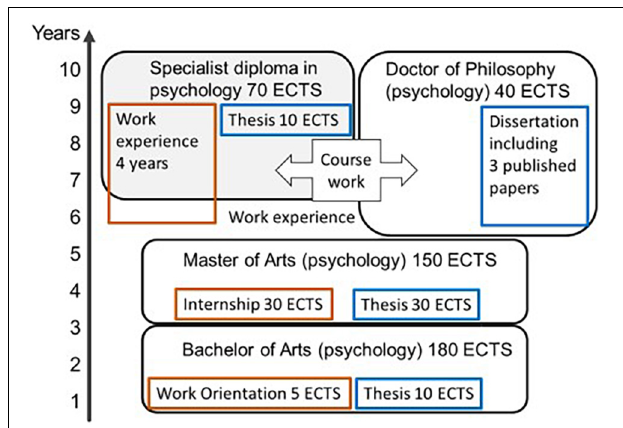
FIGURE 1 | The track for specialist education and the track for doctorate in Finland currently. Both tracks build upon a master’s degree and part of the course credits from one can be counted toward the other. Clinical work practice requirements on different levels in brown, scientific writing requirements in blue. ECTS, European credit transfer and accumulation system, 60 ECTS equal one full-time academic year.